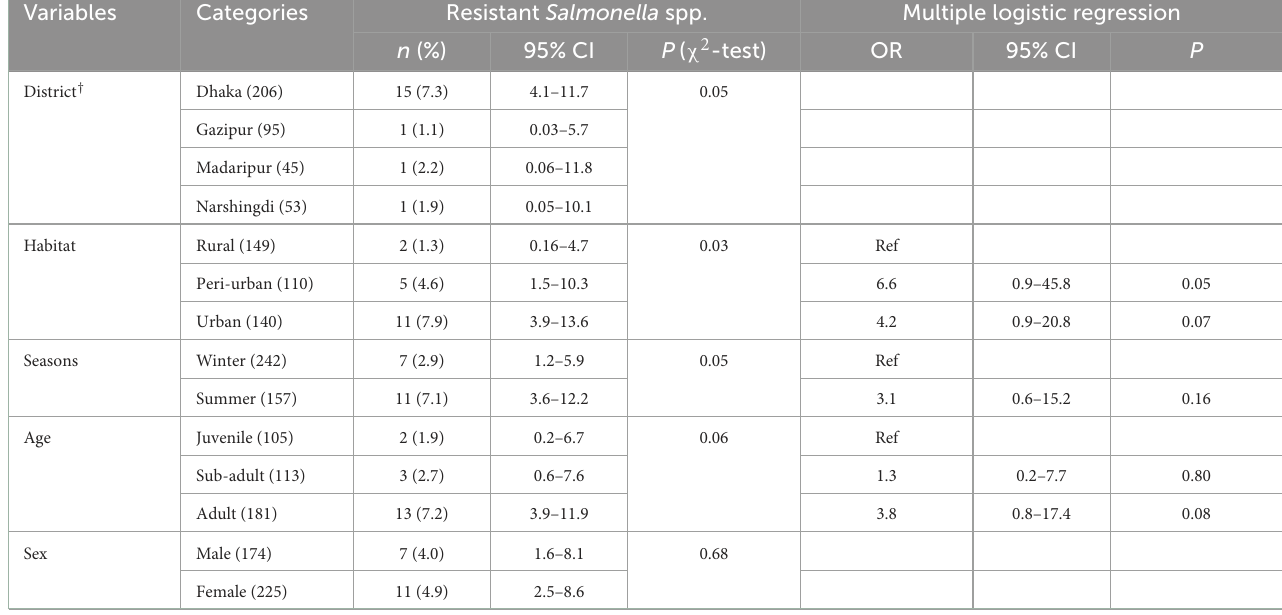
TABLE 2 Frequency distribution of resistant Salmonella spp. in rhesus macaque of Bangladesh.